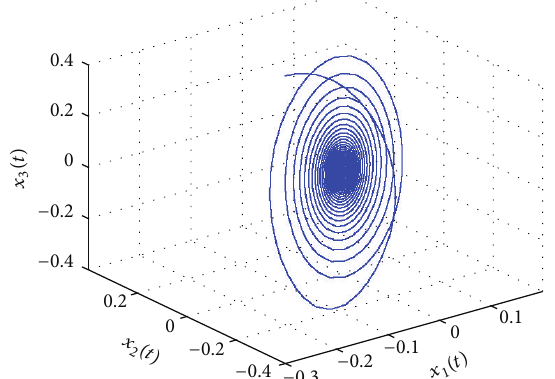
Figure 8: The phase plot of 𝑥 1 , 𝑥 2 , and 𝑥 3 when 𝜏 2 = 3.5 > 3.1610 = 𝜏 20